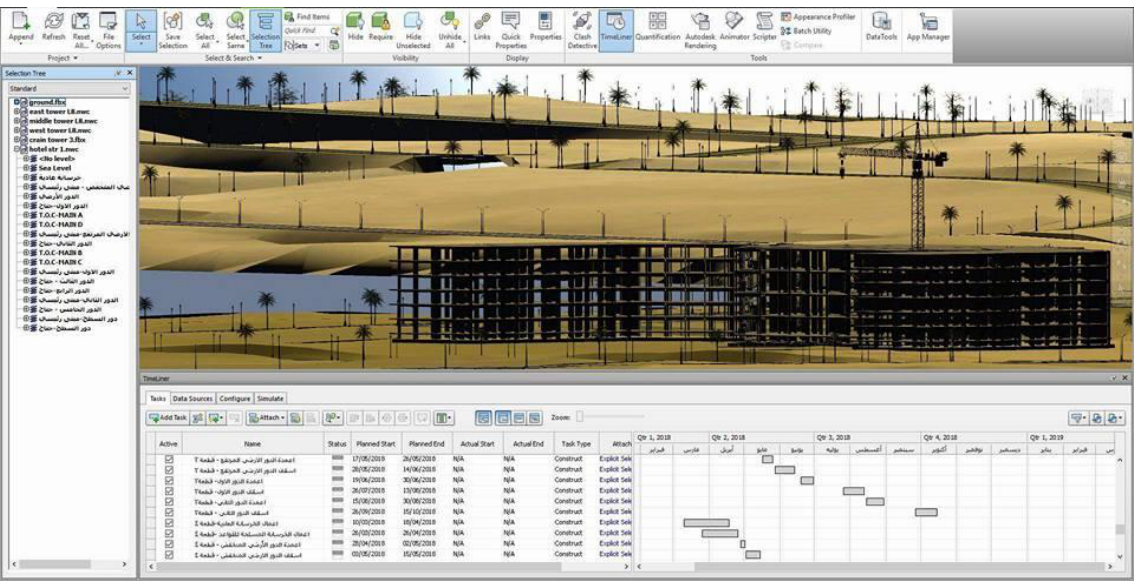
Figure 8: Navisworks (4D simulation – The military hotel